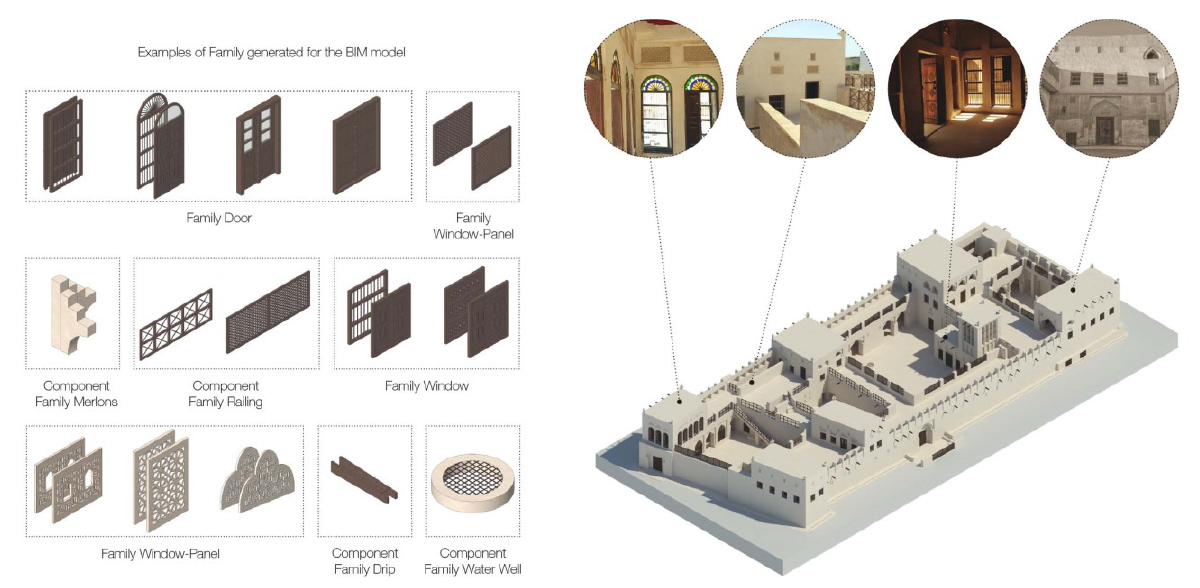
Figure 8. HBIM model, examples of detailed architectural components.